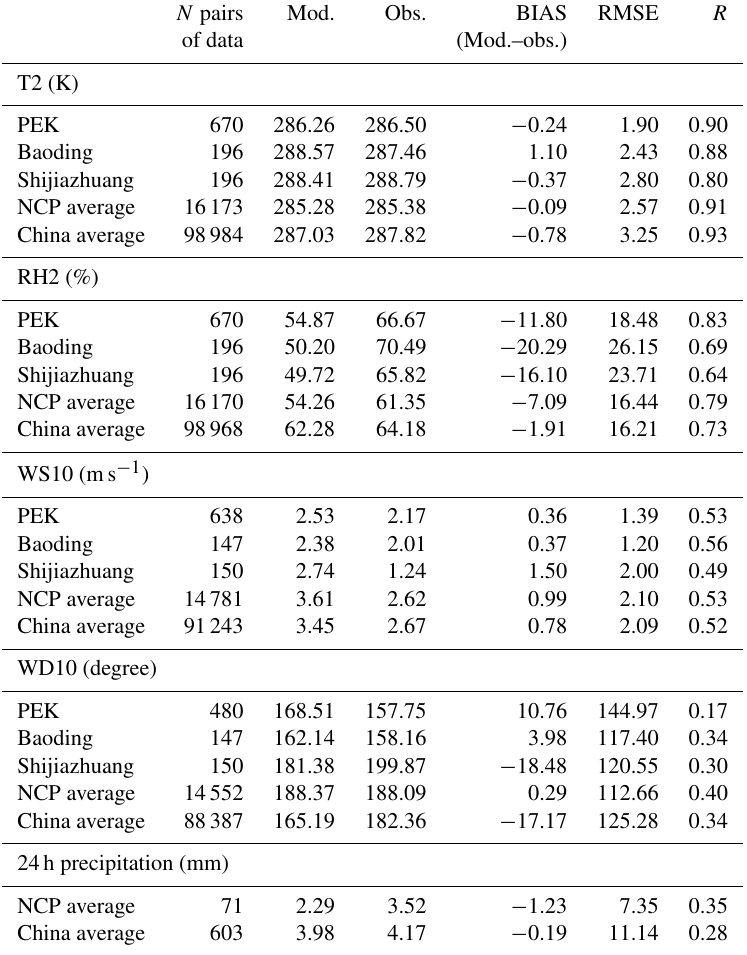
N pairs Mod. Obs.